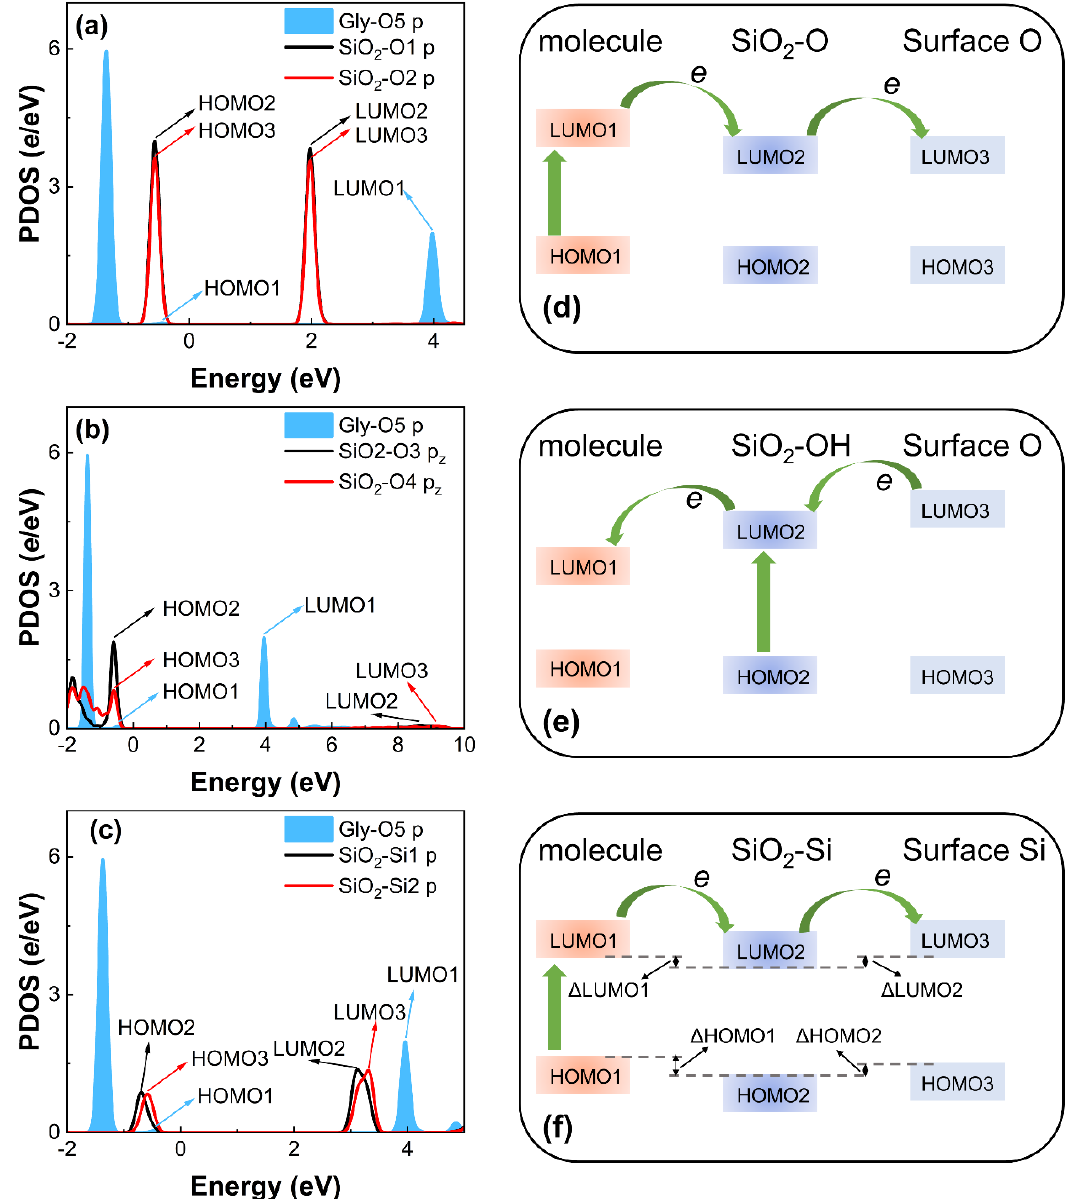
Figure 6. The PDOS electrons of the contact and neighbor atoms in ( a ) Gly and SiO 2 -O surface, ( b ) Gly and SiO 2 -OH surface, and ( c ) Gly and SiO 2 -Si surface before contact. The black curve shows the PDOS of contact O1, O3, and Si1 atoms in SiO 2 surface. The red curve shows the PDOS of neighbor O2, O4, and Si2 (adjacent Si atom) atoms in SiO 2 surface. The blue shadow denotes the PDOS of corresponding contact O5, O6, N, S and O7 atoms in isolated molecule. Fermi level is set to zero. Schematic diagrams of charge transfer mechanism of ( d ) molecule/SiO 2 -O, ( e ) molecule/SiO 2 -OH, and ( f ) molecule/SiO 2 -Si contact systems.